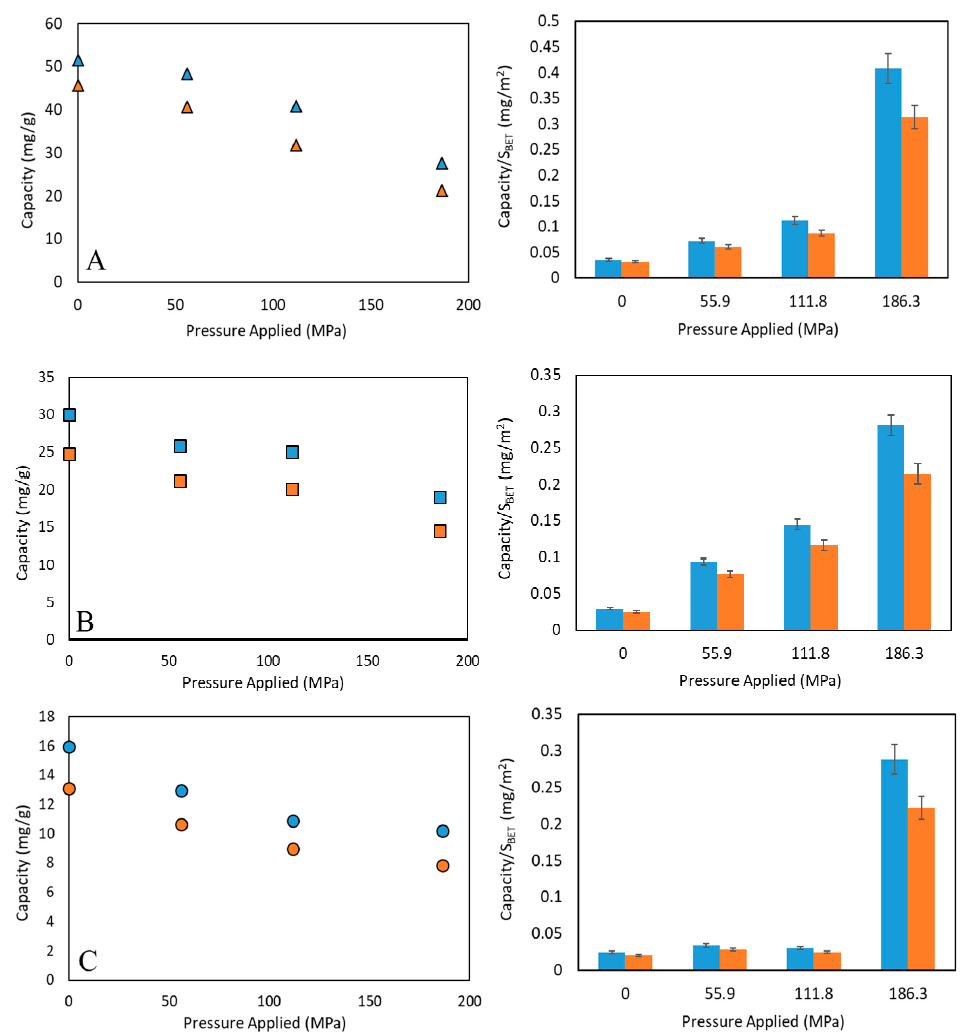
Figure 6. Adsorption capacity for pure methane (blue) and nitrogen (orange) for different applied pressures at 298 K and 0.1 MPa of total pressure (figures on the left), and its relation with BET specific surface area (figures on the right). Basolite C300 ( A , ▲ ), Basolite F300 ( B , ■ ) and Basolite A100 ( C , ● ). From Figure 6 it is observed that the relative adsorption capacity decreases are higher for N 2 than for CH 4 , and it may be related to metal adsorption centers being available, and more selective towards CH 4 than N 2 [70]. Thus, after surface area and total pore volume reduction, the available active metallic centers play a more relevant role in the selective gas adsorption, especially in Basolite C300 and A100 cases. The influence of the applied pressure in the CH 4 /N 2 selectivity (mass basis) is shown in Figure 7. The increasing slope for Basolite C300 is markedly higher than for the other materials, due to the presence of a higher percentage of metal in its structure (31.5% of copper, vs. 21.2% and 12.9% of iron and aluminum for Basolite F300 and A100, respectively). Therefore, the higher metal content in the structure, the greater the selectivity-increasing trend with applied pressure.